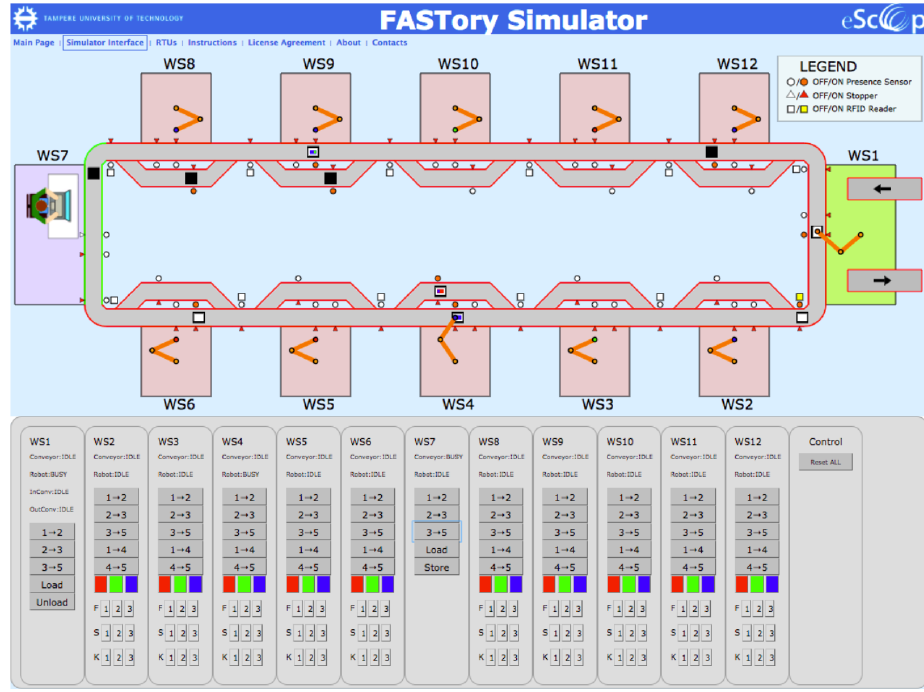
Figure 5. The FASTory Simulator (http://escop.rd.tut.fi:3000/).